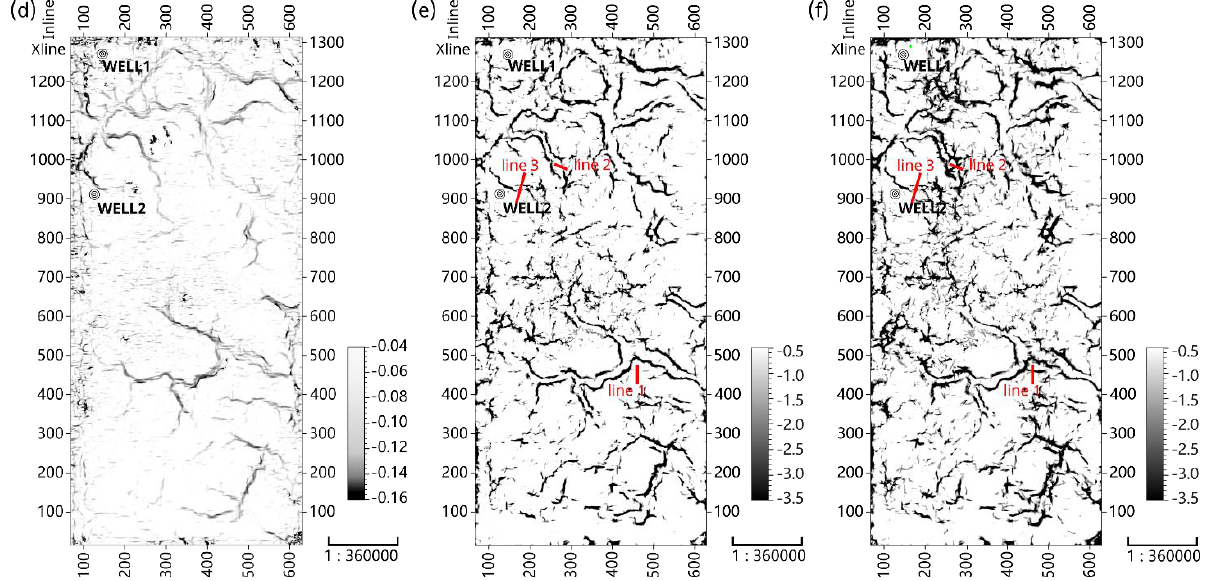
Figure 4. Comparison of fault detection results of the target layer. Line 1, line 2, and line 3 in red line are three arbitrary lines for further comparisons. ( a ) Amplitude, ( b ) coherence, ( c ) dip, ( d ) curvature, ( e ) PC attribute, ( f ) PC attribute (new method).